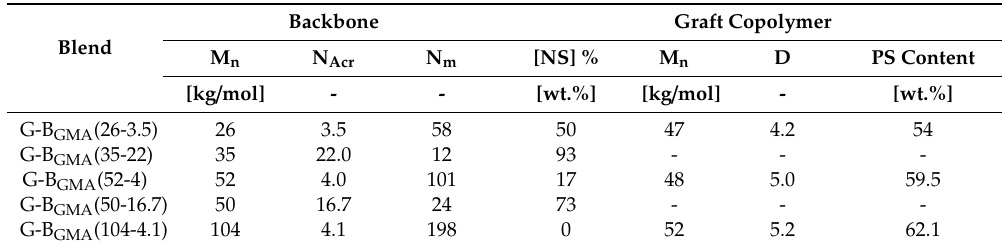
Table 3. Non-soluble fraction and molecular weight distribution of PBA-g-PS /